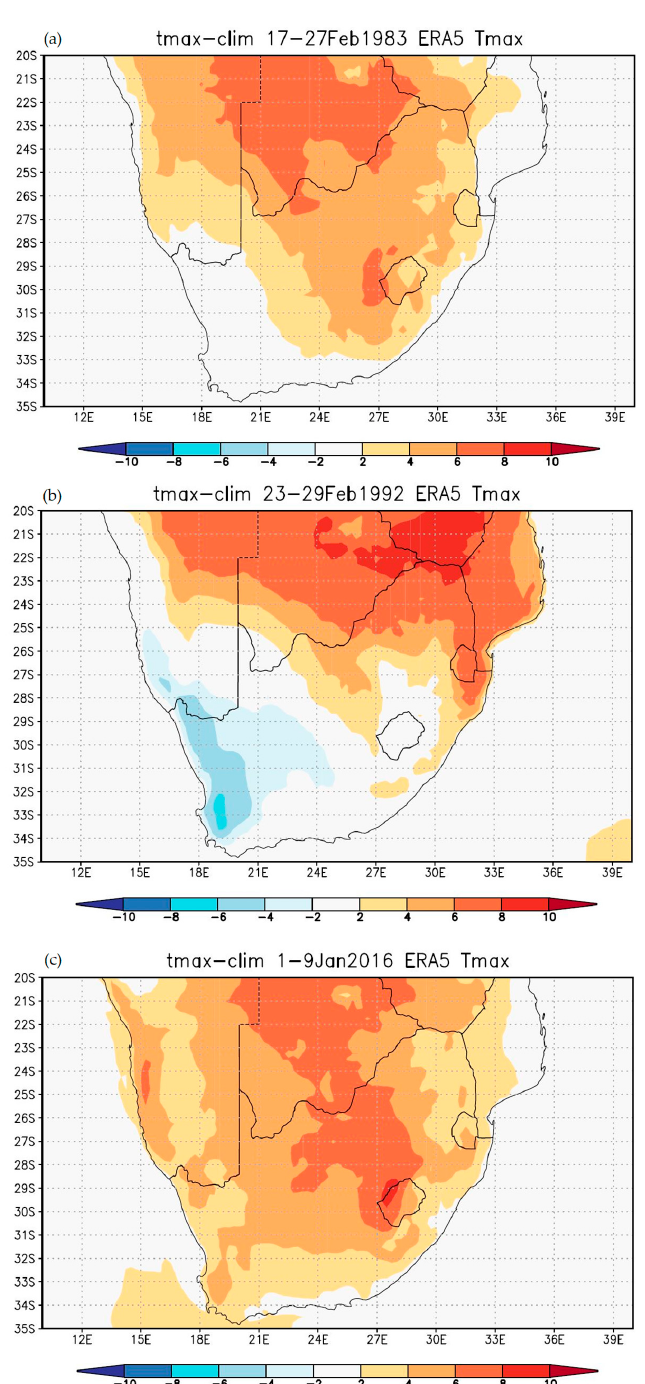
Figure 9. Temperature anomalies for the ( a ) 17–27 February (Feb) 1983 HW, ( b ) 23 February (Feb)